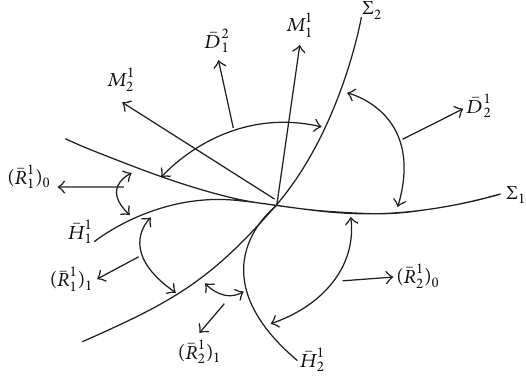
Figure 6: 𝑁 1 (𝑠 1 ) and 𝐿 1 (𝑠 1 ) for 0 ≤ 𝑠 1 ≪ 1 , ] ∈ 𝐻